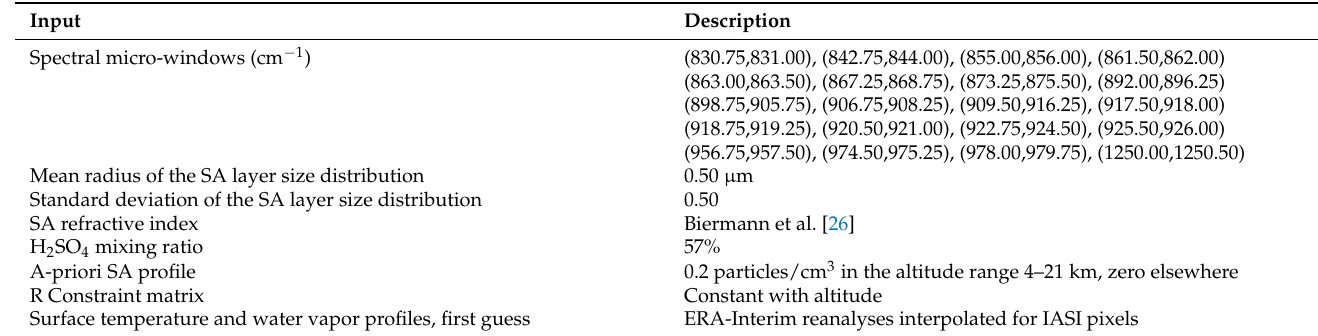
Table 1. AEROIASI-H2SO4 main